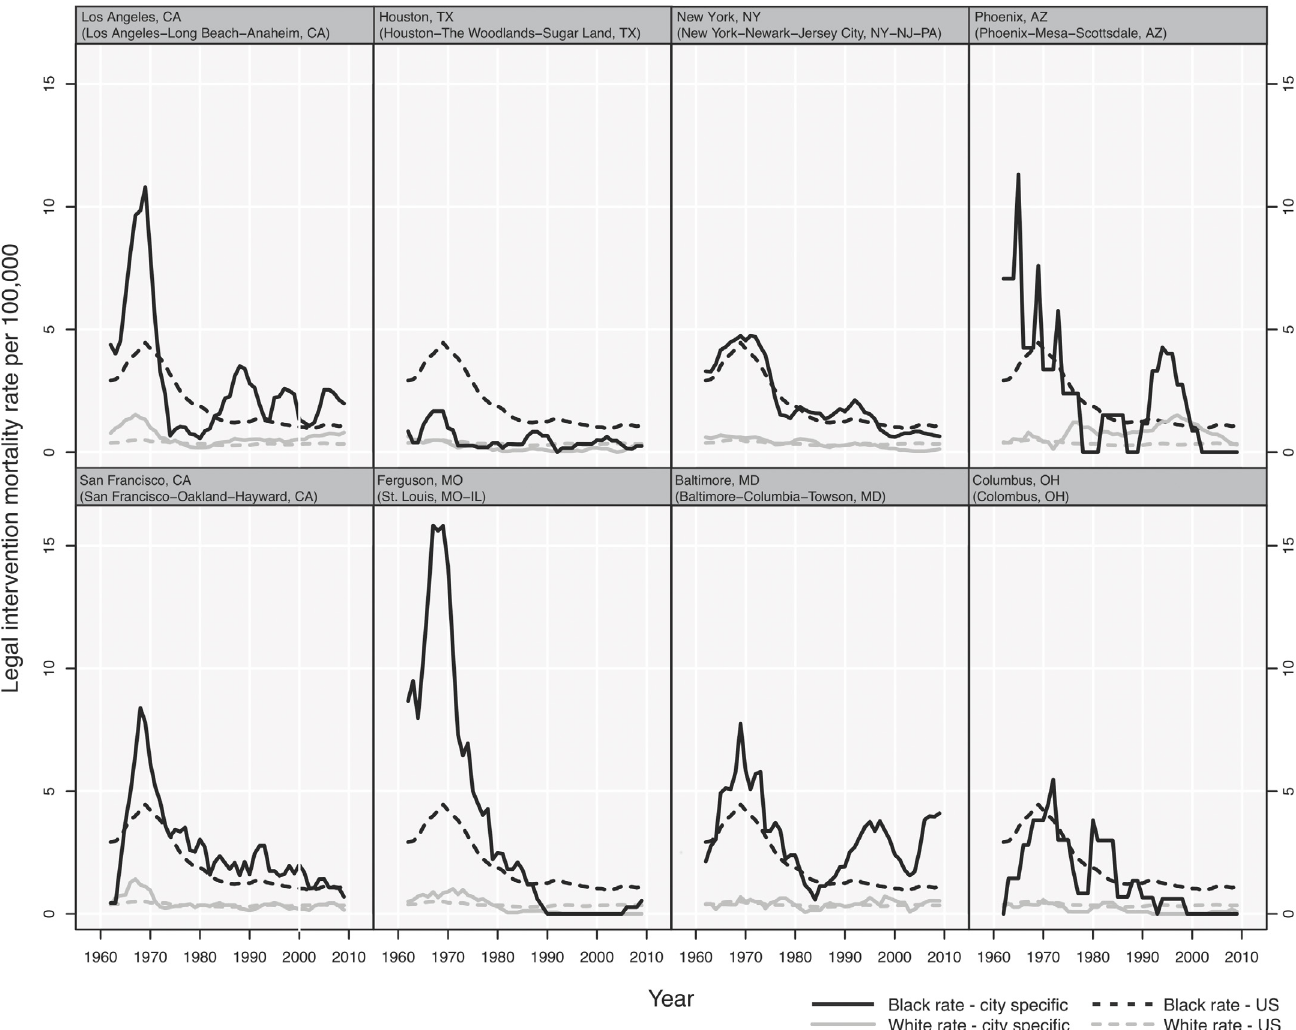
Fig 1. US deaths due to legal intervention: national and city-specific annual 5-year moving average rate (per 100,000) among US black men and white men ages 15 – 34, 1960 – 2011.